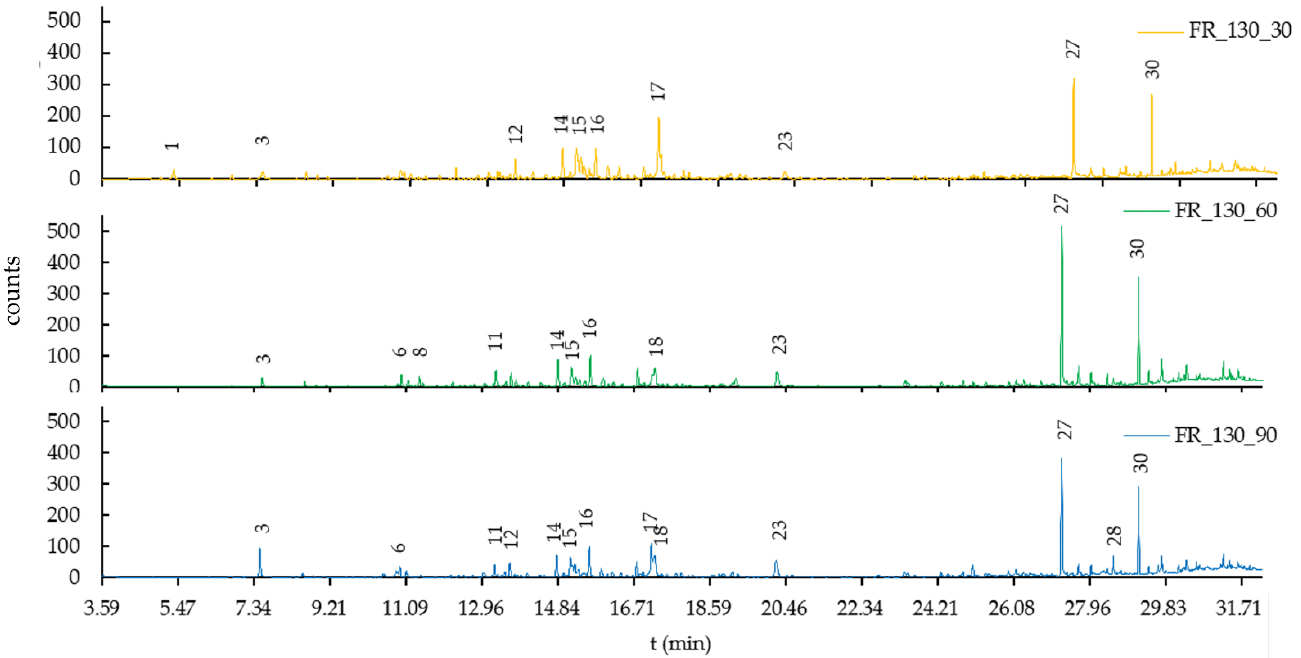
Figure 5. GC-MS diagram of the forest residue (FR) hydrothermally treated at 130 °C with 30, 60 and 90 min holding times, see peak numbers in Table 6.